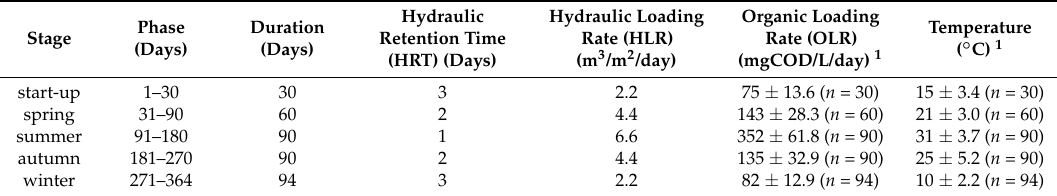
1 Values are given as mean ± standard